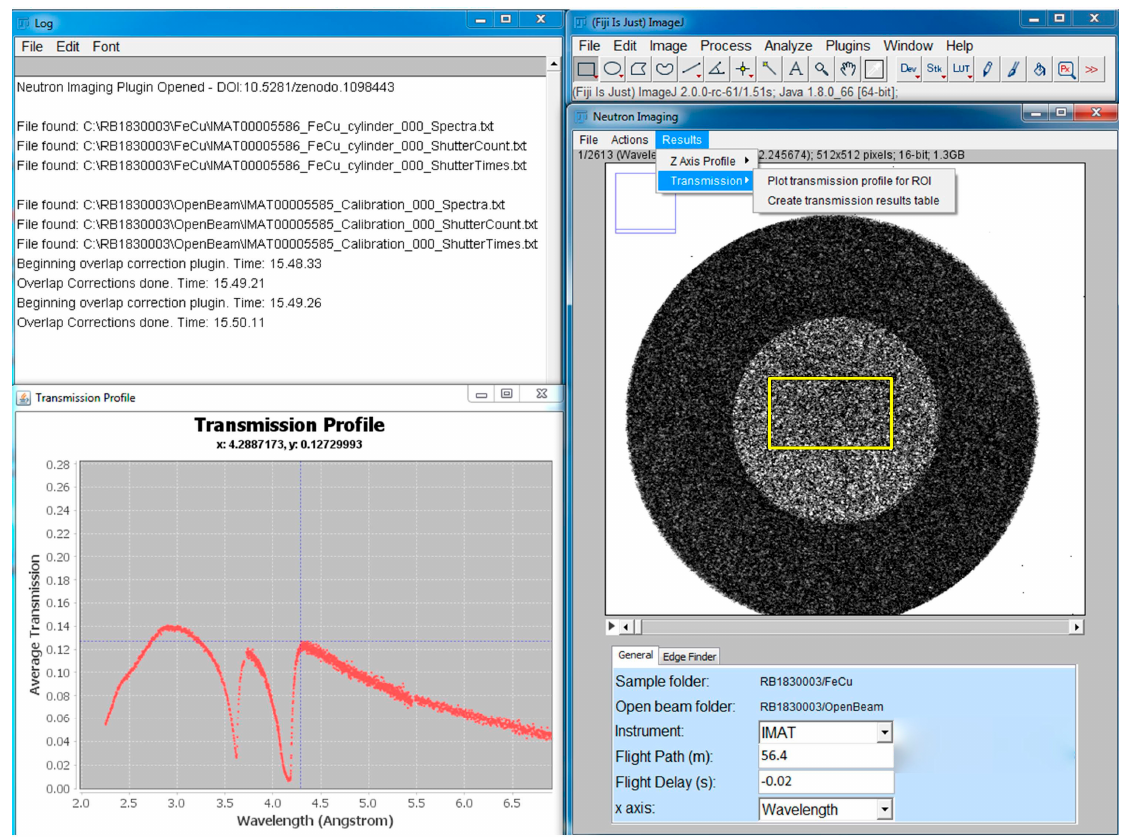
Figure 9. IMAT ImageJ plugin. The radiography on the right corresponds to a 40 μ s time slice at 12 + 20 = 32 ms. On the left, a copper Bragg edge spectrum, averaged for the yellow-box selection, is displayed.